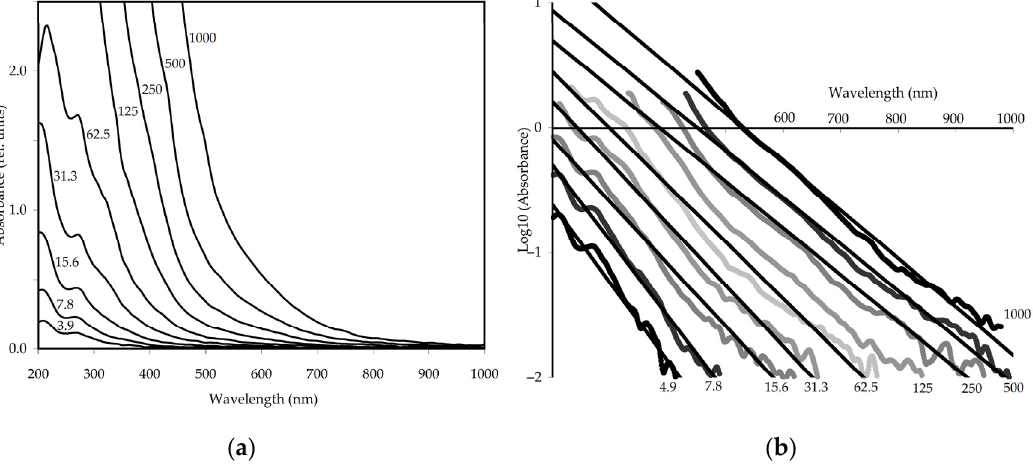
Figure 5. UV-Vis spectra of E. angustifolium melanoidin (EAM) in concentration range 3.9–1000 μ g/mL ( a ) and diagrams of the wavelength–logarithm relationship of absorbance in the concentration range 3.9–1000 μ g/mL ( b ). Some spectral characteristics of EAM were studied, such as the logarithm of the absorbance–wavelength linearity [12], chromatic coefficient E 465 /E 665 [77], and the colour value (E 1% 1 cm ) [64], which are usually used to characterize the chromatic properties and aromaticity level of melanoidins. The relationship of the logarithm of absorbance versus wavelength for EAM at pH 12.0 was linear (Figure 5b) as for most melanoidins [78]. The linearity of this relationship was stable independently of the melanoidin concentration; however, solutions with a higher concentration had better linearity in the long-wavelength region while less concentrated solutions showed better linearity at short wavelengths. The values of the determination coefficient (r 2 ) were 0.9671–0.9904 for EAM solutions with a concentration range of 3.9–1000 μ g/mL. The logarithmic slope of absorbance for solutions with different concentrations was less than 0.0070 and varied from 0.0037 to 0.0062. The chromatic coefficient E 465 /E 665 of EAM was low (6.71 ± 0.14), indicating a small number of aliphatic fragments and a high content of aromatic substituents in melanoidin [77]. The colour value of EAM (E 1%1 cm ) at 190 nm was 507 ± 10, higher than that of melanoidins from Orthosiphon stamineus (81) [12], Osmanthus fragrans (60) [64], and the general pigment (45) [79], which means a richer colour of EAM solutions. 3.2.4. Fourier-Transform Infrared (FT-IR) Spectroscopy The FT-IR spectrum of EAM (Figure 6) showed intense bands of hydroxyl groups at 3404 cm − 1 as well as bands in the region 1000–1800 cm − 1 caused by variously substituted C-H, C-O, and C-N functional groups [80]. In this spectral range, some specific bands were due to the presence of free carboxyl groups (1715 cm − 1 ); aromatic fragments C=C and C=O (1623 cm − 1 ); aromatic C-C groups and an amide II band (1506–1522 cm − 1 ); aliphatic groups C-H and phenolic hydroxyls (1456 cm − 1 ); variously substituted fragments C-N, N-H, and C-H (1360 cm − 1 ); phenolic carbonyls and C-H (1237 cm − 1 ); and ester bonds C-O-C and phenolic groups C-O (1039 cm − 1 ) [12,42]. As for the vibrations in the range of 1506–1522 cm − 1 , they resulted from the system of aromatic rings and COOH groups not from amide II, due to the low nitrogen content in the EAM. Signals in the region below 880 cm − 1 were caused by the aromatic protons of the melanoidin skeleton, and the weak bands at 2849–2970 cm − 1 were caused by the aliphatic fragments C=H, CH 2 , and CH 3 , which have a low content [80].